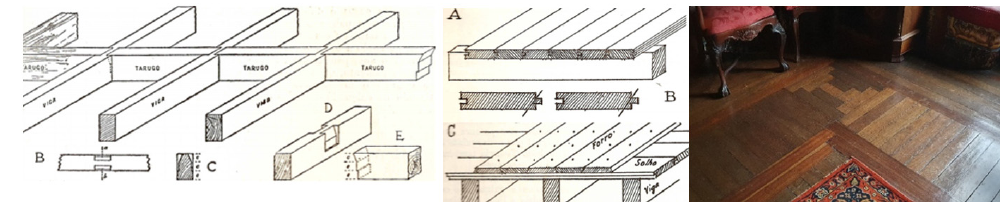
Figure 26. Wooden structure of the raised floors.